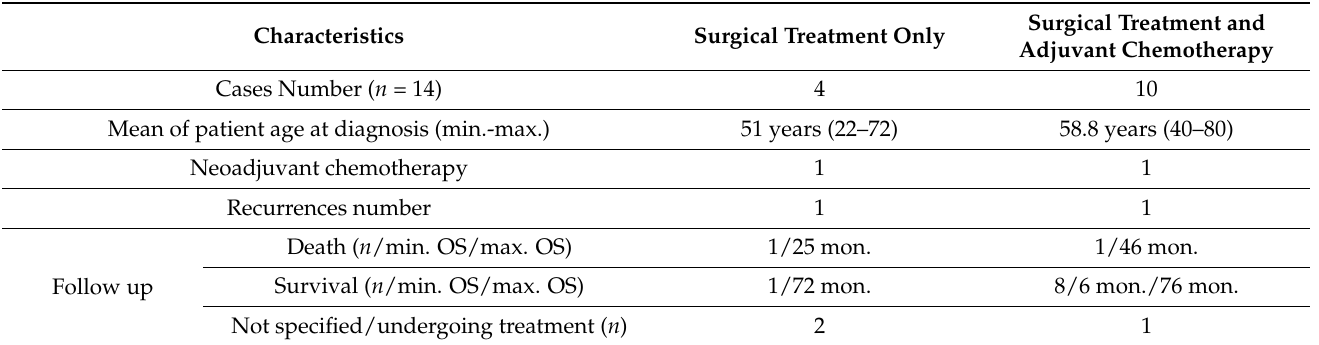
Surgical Treatment and Adjuvant Chemotherapy